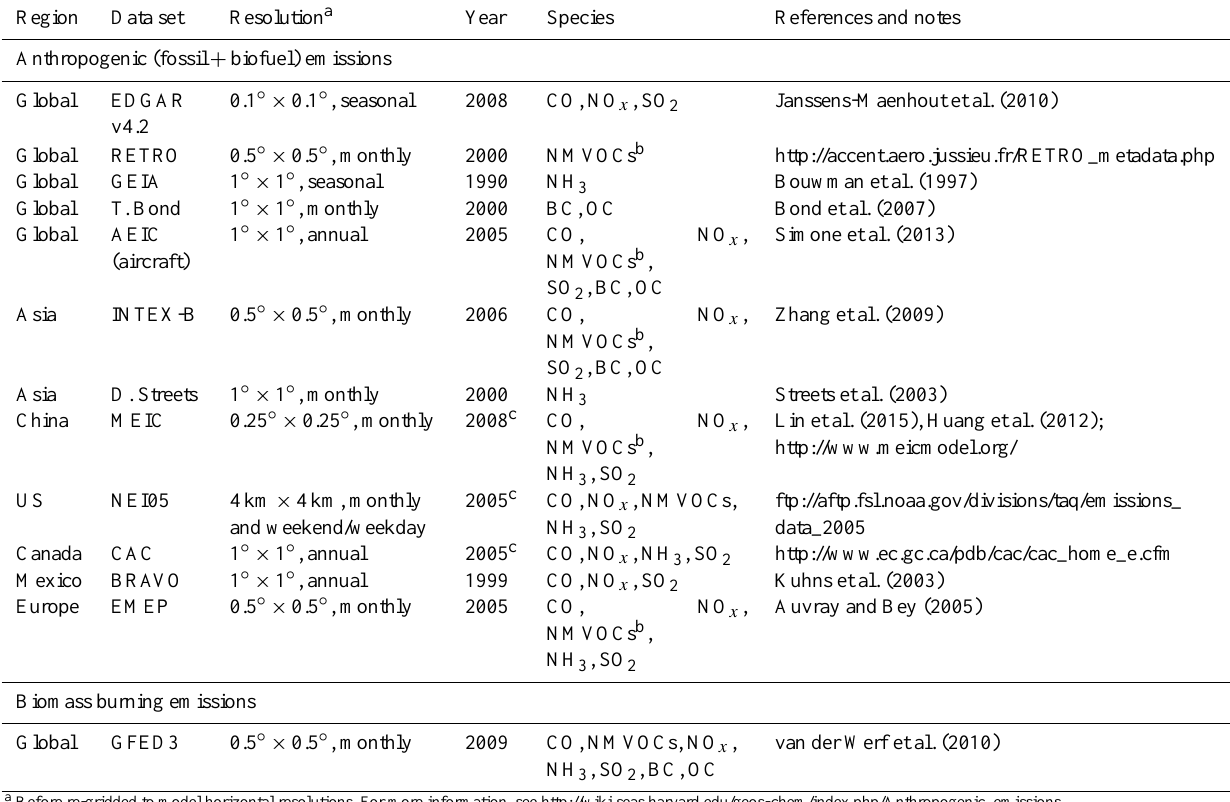
Table 1. Anthropogenic and biomass burning emission inventories used by GEOS-Chem. Region